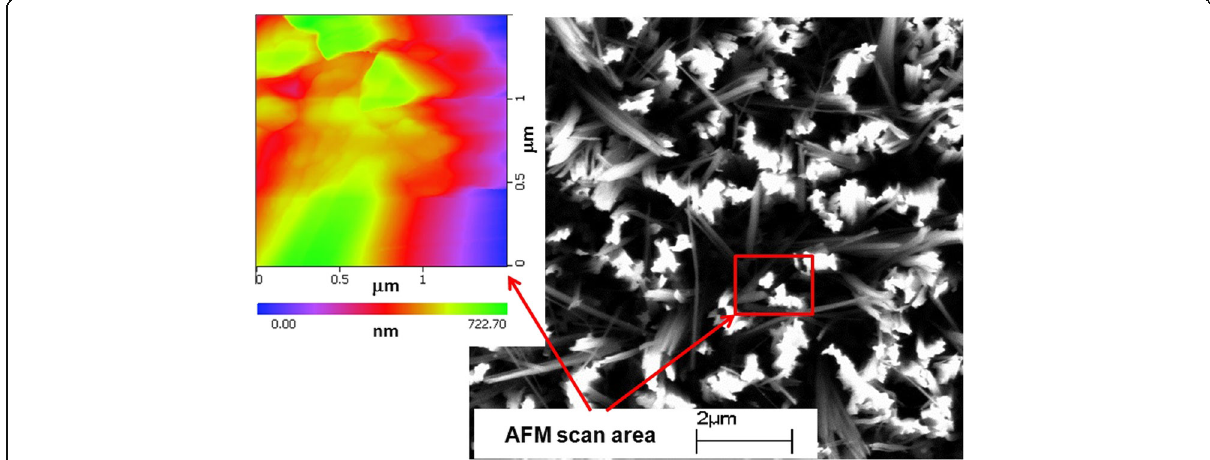
Fig. 9 SEM and AFM images of the vertically aligned SiNWs. A triangle-shaped wire was chosen for the electrical measurement by